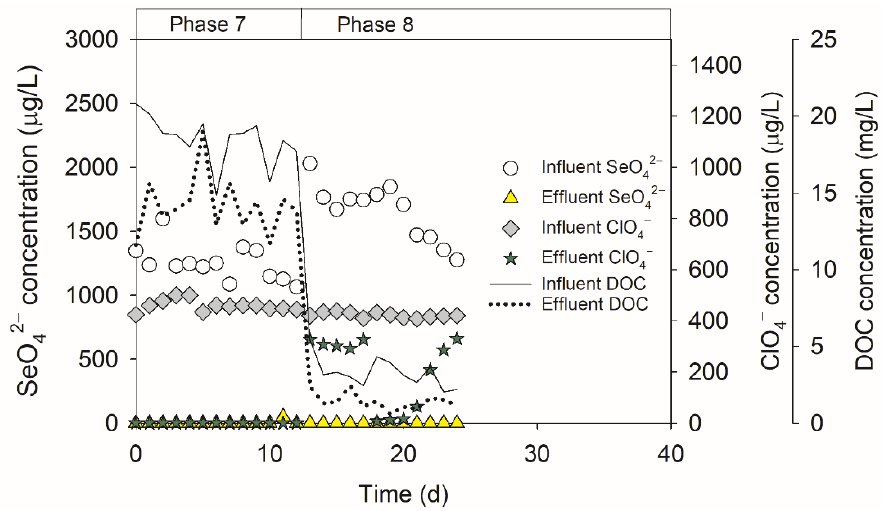
Figure 4. E ffl uent selenate and perchlorate profiles in the biofilm reactor when carbon substrate was limited.